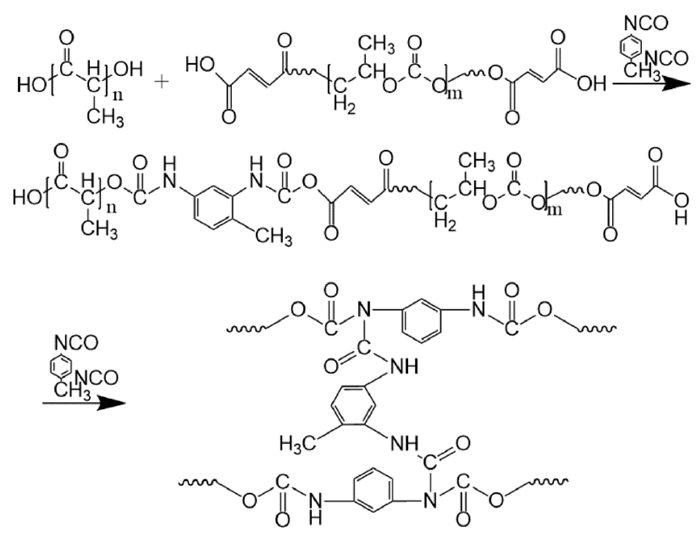
Figure 1. Chain extension reaction of PLA and PPC.